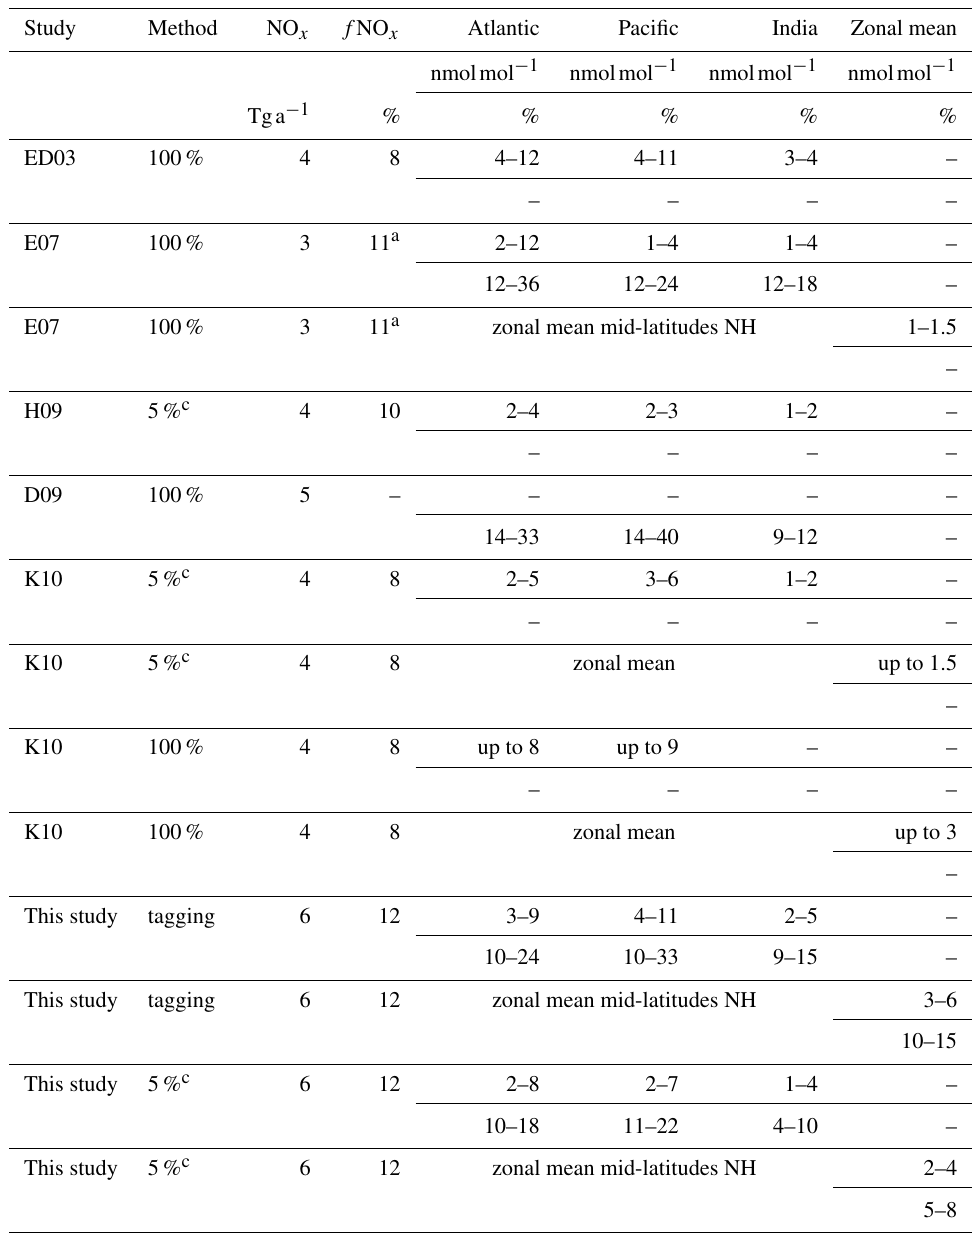
Table 4. Summary of previous global model studies investigating the contribution and impact of shipping emissions to ozone. Method denotes the percentage of the emissions reductions (perturbation). The other columns list the amount of shipping emissions and the fraction ( f ) compared to all emissions used in the studies for NO x (in Tg ( N ) a − 1 ). The four rows on the right list the contribution of the shipping category as estimated by these studies in mixing ratios (upper row) and/or percent (lower row). Where possible, we show the estimated contribution for the geographical regions defined in Sect. 2 and zonal average values. For the geographical regions we give only the values larger than the background values. All contributions are given to near-ground-level ozone and for July conditions. The table is ordered by the year of publication. A “–” indicates missing